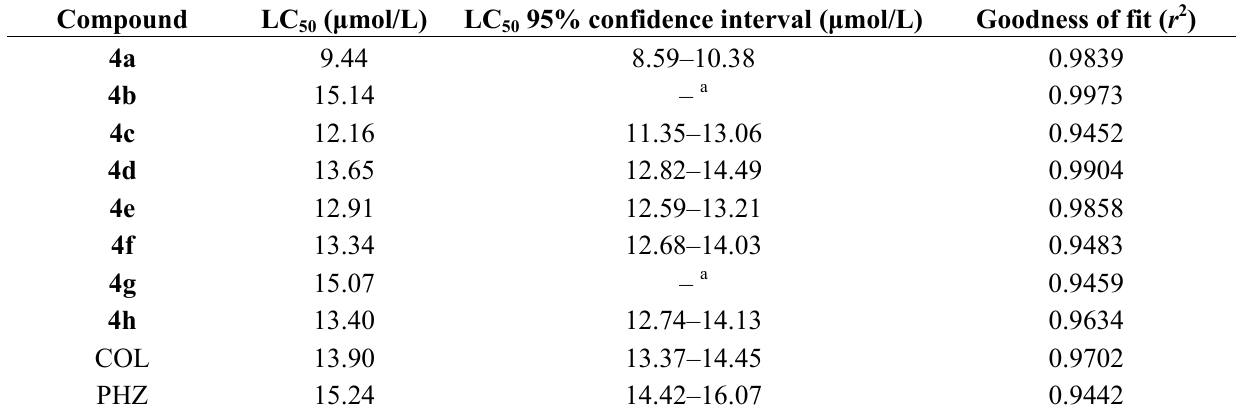
Table 2. The toxic activity of compounds 4a – h in the D . magna